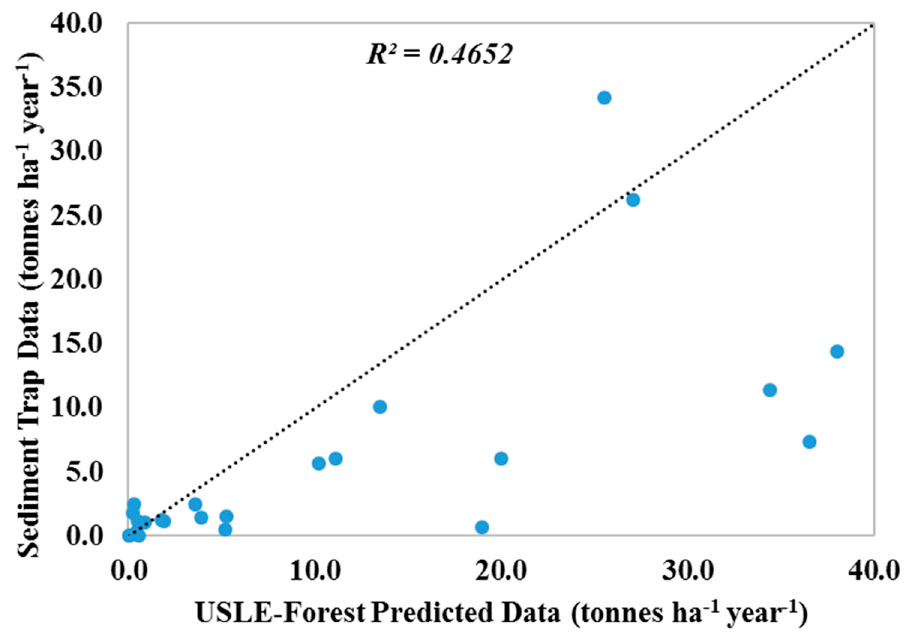
Figure 8. Linear relationship of USLE-Forest modeled data and actual measured erosion data. Line on graph represents a 1:1 relationship.